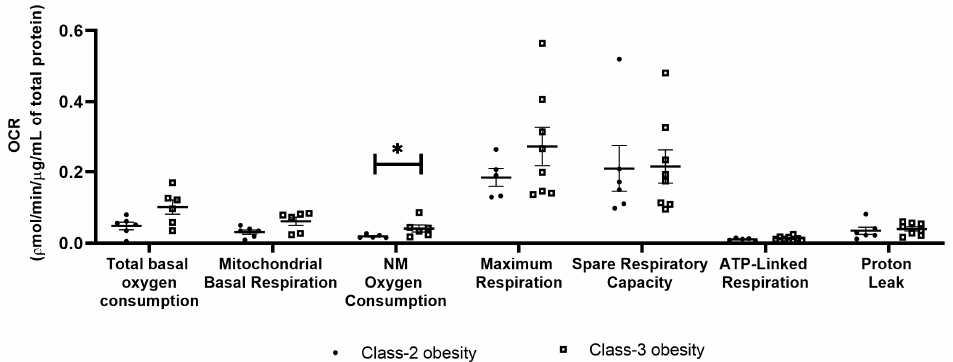
Figure 1. Comparison of VAT respiratory parameters of patients with obesity class 2 or 3 (Mann–Whitney test * p < 0.05). OCR—Oxygen Consumption Rate; NM—Non-mitochondrial.